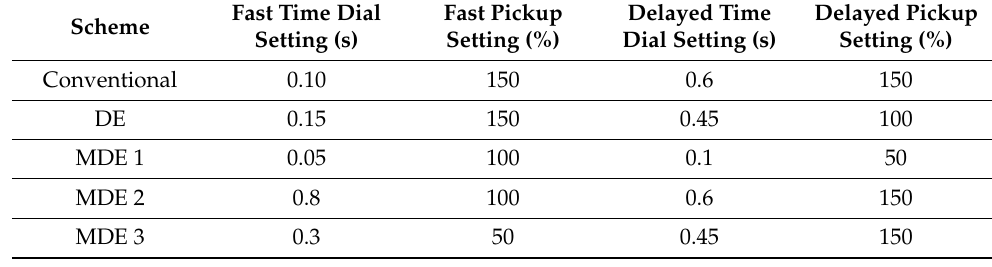
Table 2. Time Dial and Pickup settings for Conventional, DE and MDE schemes.